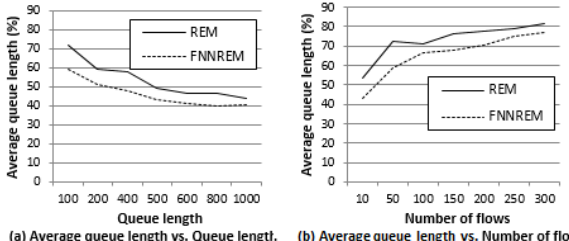
Figure 15. Utilization of the queue of active queue management